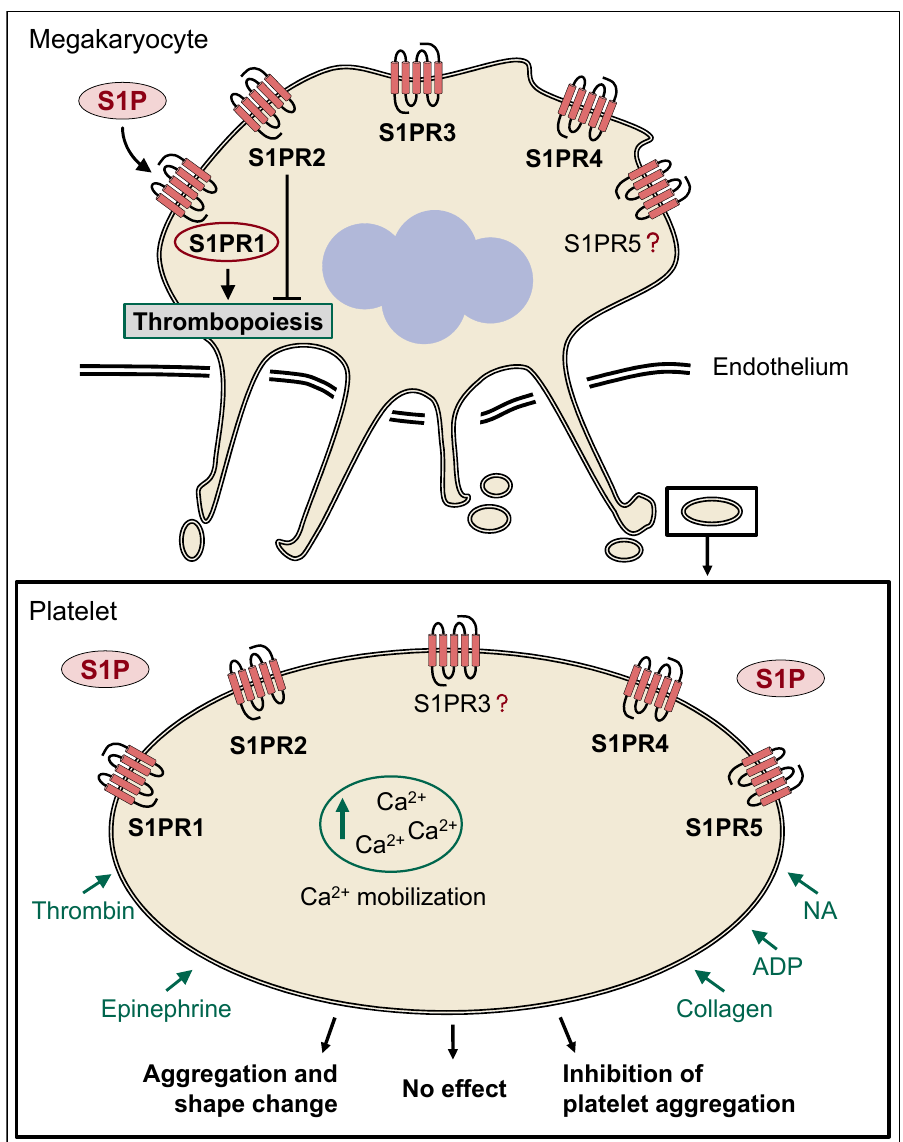
Figure 3. Effects of S1P on megakaryocytes and platelets. At present, the expression of S1PR1, 2, 3, and 4 on MKs has been detected. S1P regulates thrombopoiesis through S1PR1. However, thrombopoiesis is suppressed by the activation of S1PR2. Different autocrine effects on platelet activation are discussed. Evidence suggests the possible involvement of S1PR1, 2, 4, and 5 in platelet responses, indicating that presumably all members of the S1PR family are present in MKs/platelets. In addition to no effect or even inhibitory effects on platelet activation, a platelet-activating or aggregation-promoting effect of S1P on platelets when combined with thrombin, epinephrine, NA, ADP, or collagen has been described. In addition, an increase in cellular Ca 2+ levels after S1P stimulation is under discussion. ADP, adenosine diphosphate; MK, megakaryocytes; NA, noradrenalin; Ca 2+ , calcium; S1P, sphingosine-1-phosphate; S1PR1–5, S1P receptors 1–5; ?, unclear to date.